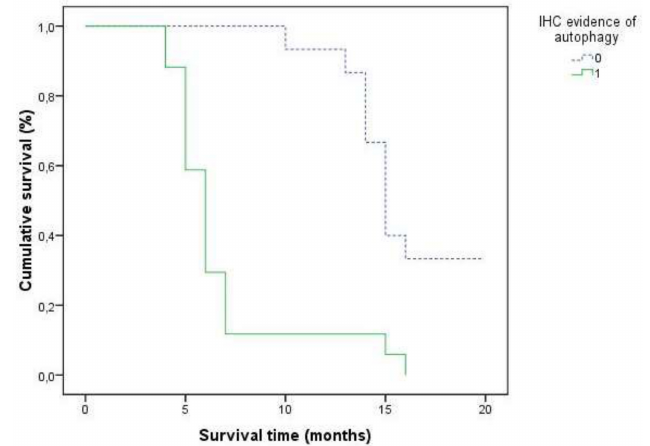
Figure 2. Overall survival curves of all cases of gastric tubular adenocarcinomas in relation to immunohistochemical evidence of